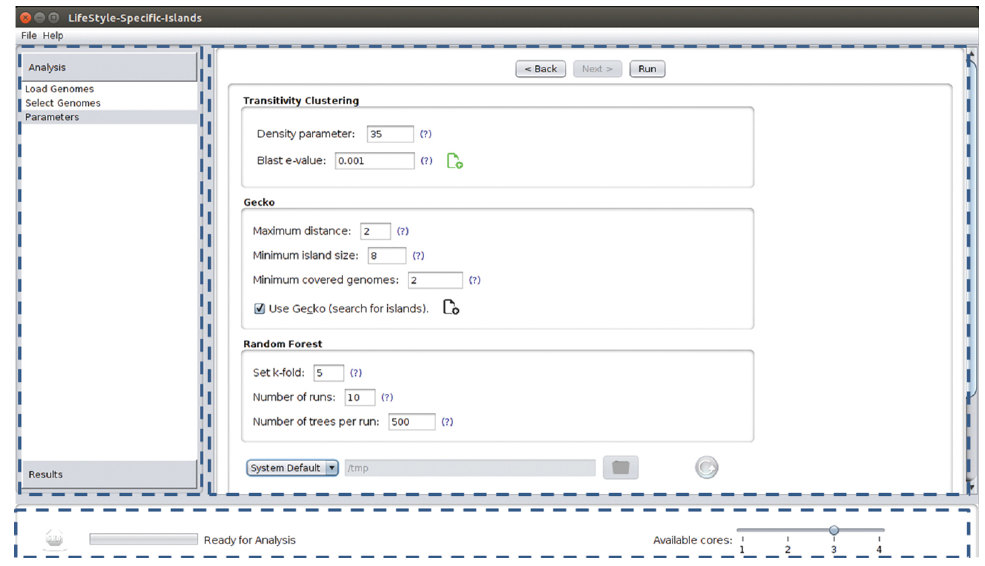
Figure 2: LiSSI software layout. Top-left the selection panel with a tab for Analysis and Results; Top-right the main panel, where all instructions and results will be displayed; and Bottom, the progress